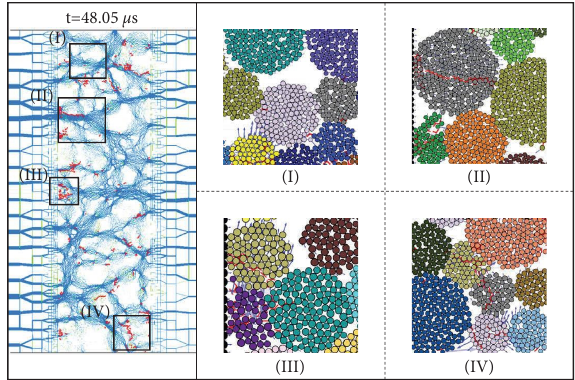
Figure 10: Breakage mode of the sand specimen during the nu- merical compression test (stage